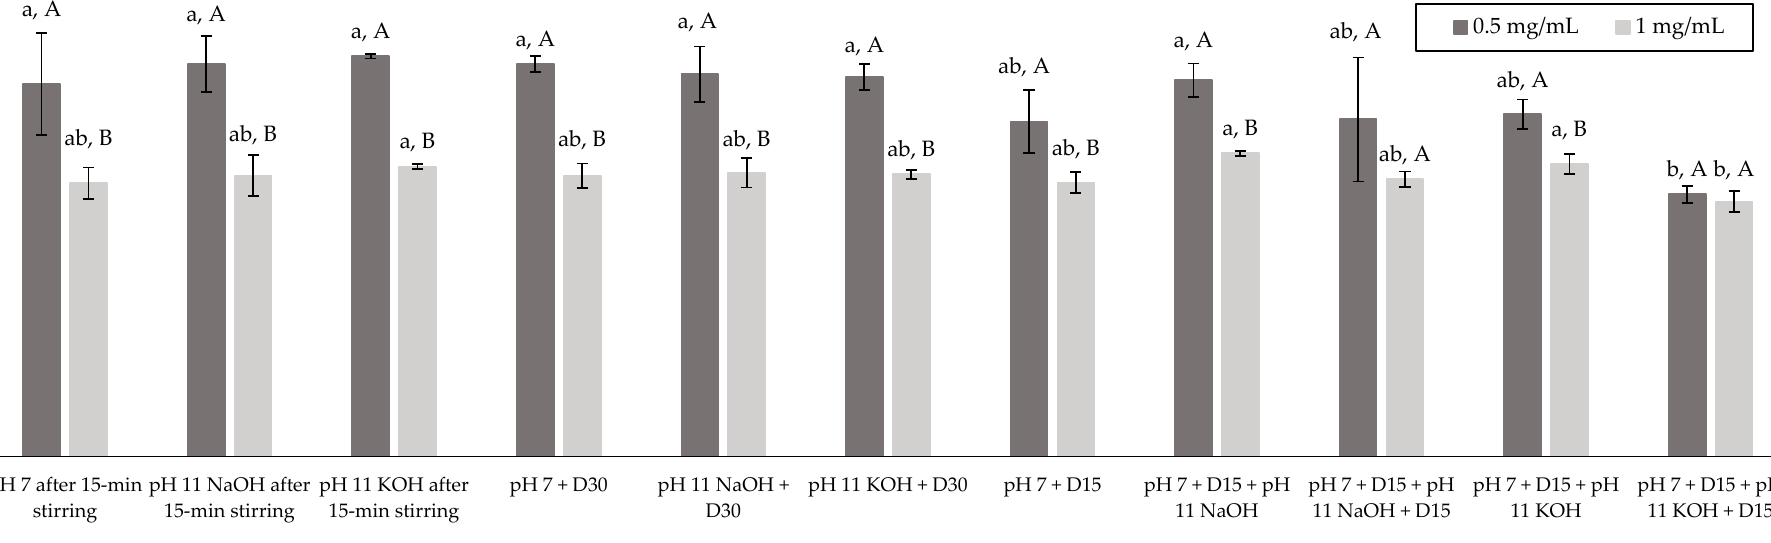
Figure 2. Antioxidant activity of the HMH solutions (µmol TE/g) corresponding to the different tested conditions and determined by the ORAC test (mean ± standard deviation). Values with different lowercase letters (a,b) within the same concentration are significantly different p < 0.05 (Tukey test); values with different uppercase letters (A,B) within the same condition are significantly different p < 0.05 ( t -test).